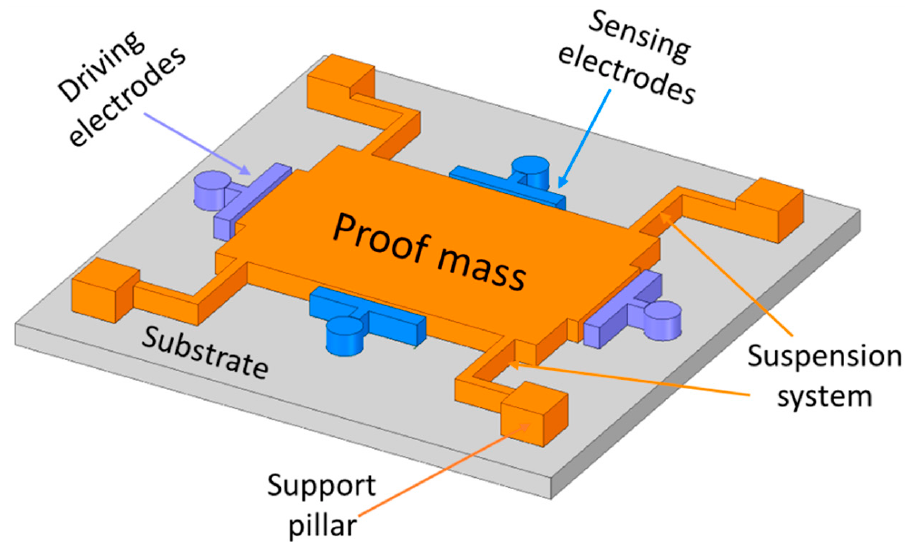
Figure 2. Schematic architecture of a single proof mass vibrating gyroscope.